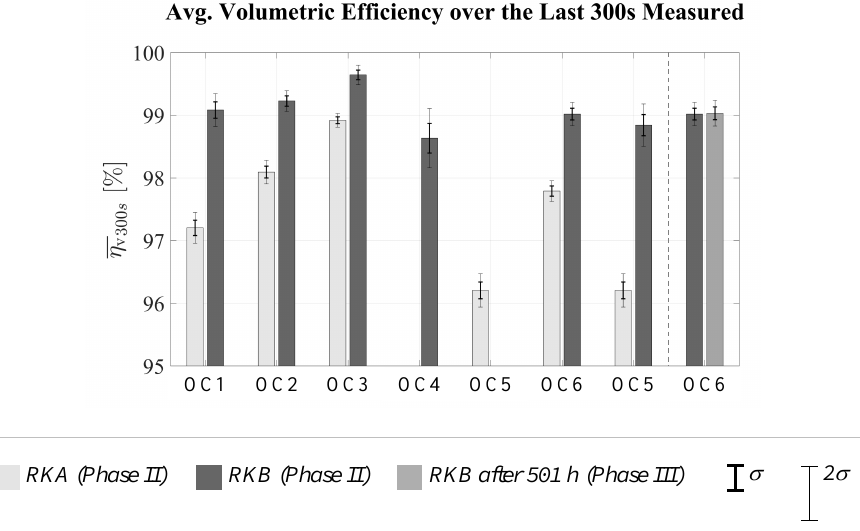
Figure A2. Average volumetric efficiency over the last 5 min